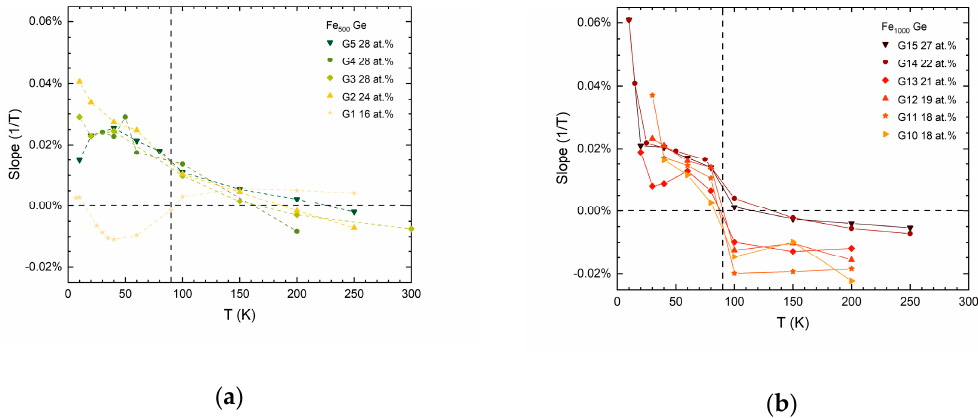
Figure 6. Slope of high field magnetoresistance vs. temperature of ( a ) Fe 500 -Ge and ( b ) Fe 1000 -Ge nanocomposite samples. Fe 1000 -Ge samples exhibit a jump to positive slopes around 90 K. A common trend is the increase of the slopes with decreasing temperature.